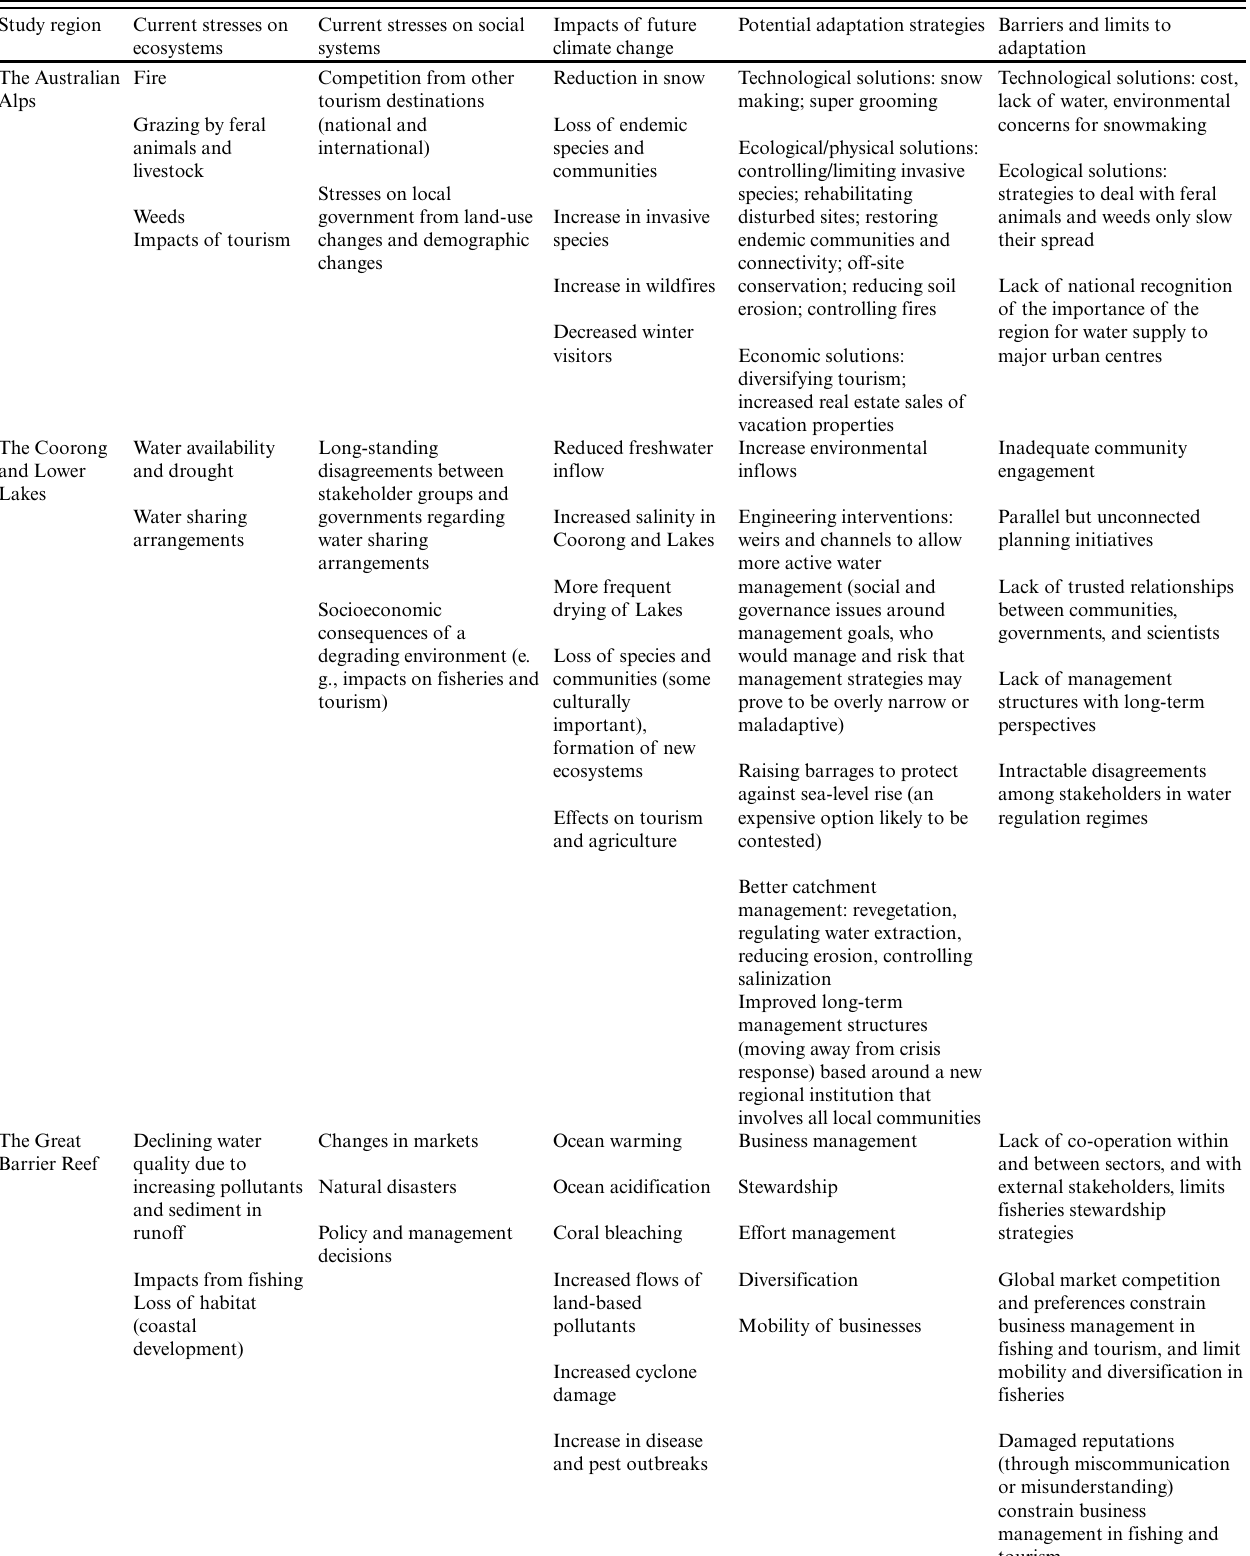
Table 3 . Summary of results from six case